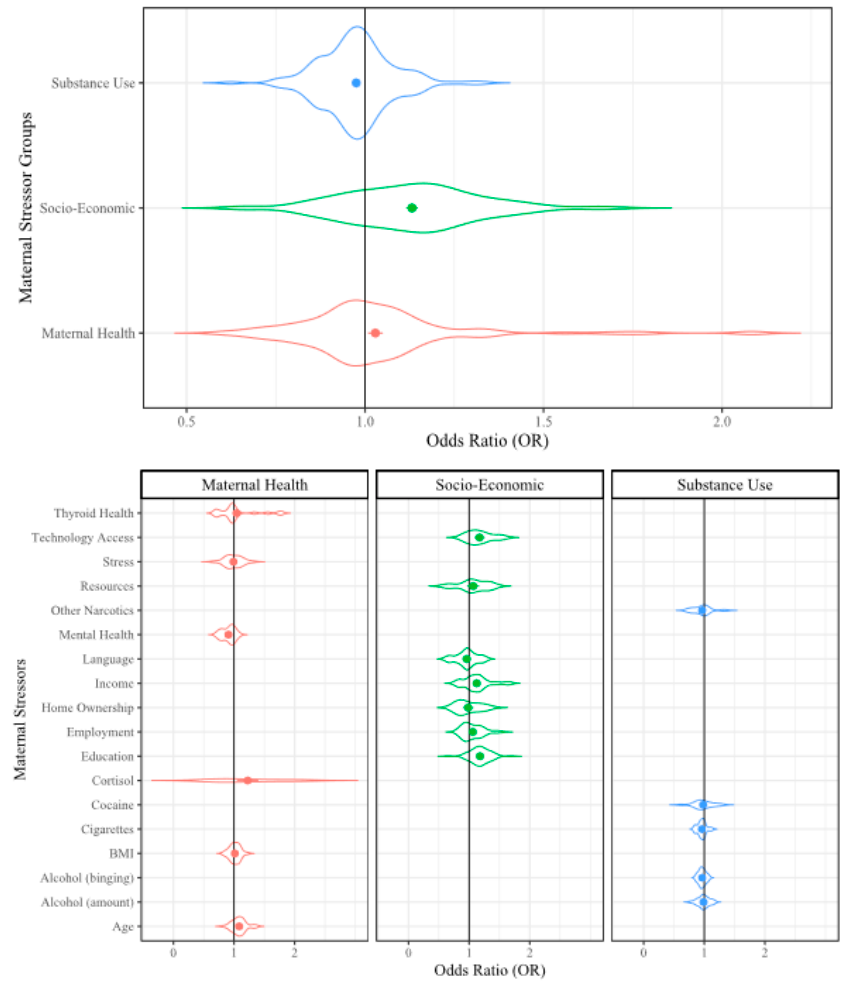
Figure 1. Violin plot of the maternal stressors that may influence cognitive development. Violin width represents the distribution of the Odds Ratios (OR), the height represents density of the ORs; dots represent mean OR, error bars represent mean standard error (SE). BMI denotes body mass index.